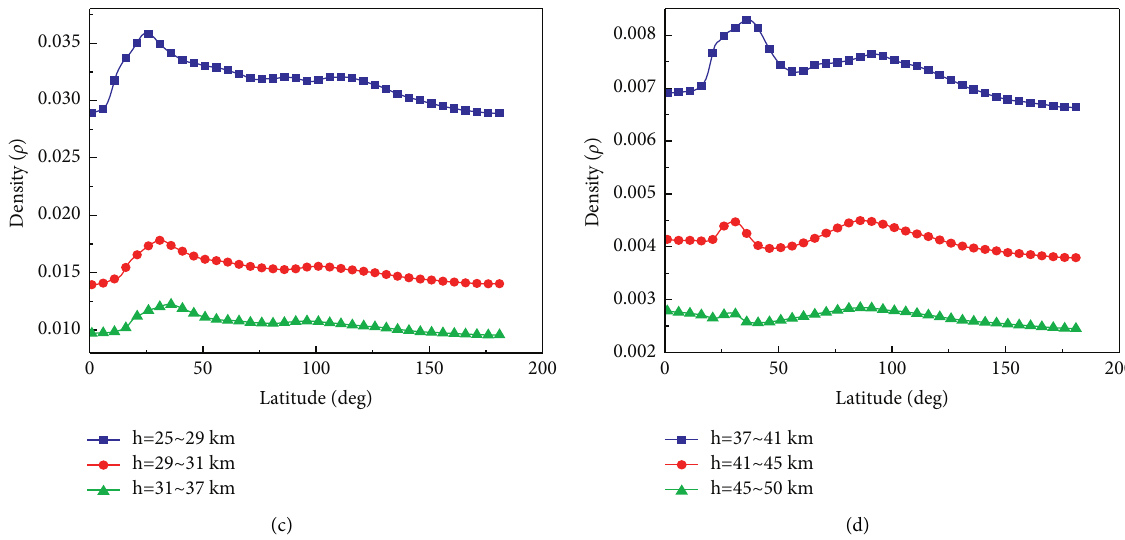
Figure 4: Variation of atmospheric density with latitude at different altitudes. (a) Height range from 1 to 13km; (b) height range from 13km to 25 km; (c) height range from 25km to 37 km; (d) height range from 37 km to